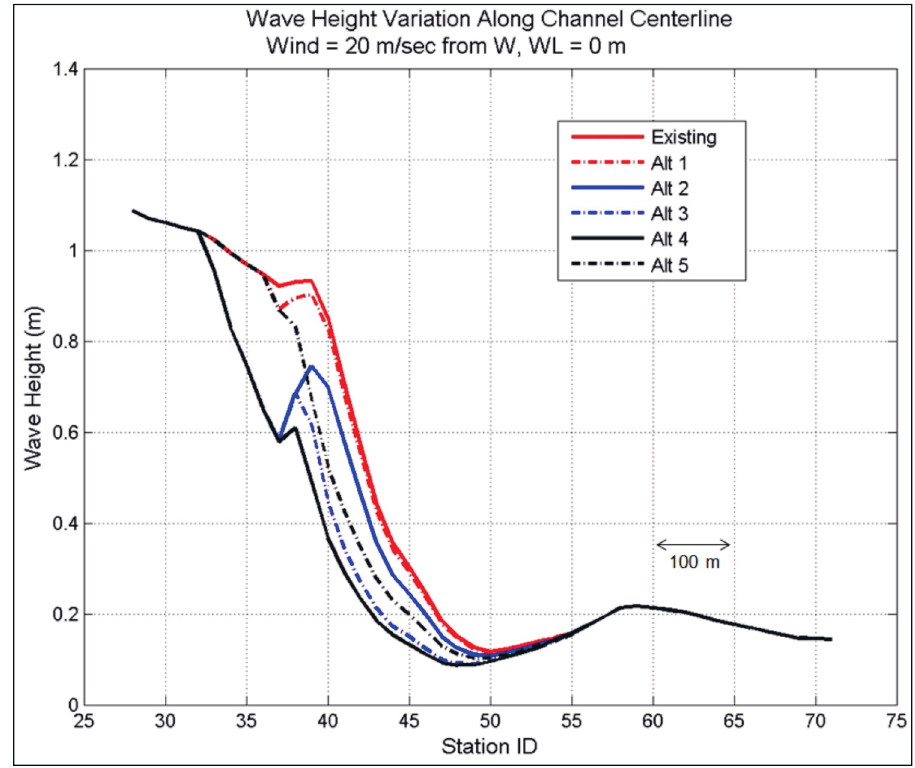
Figure 21. Model wave heights in the west channel for 50-year design wind from W and WL = 0 m.